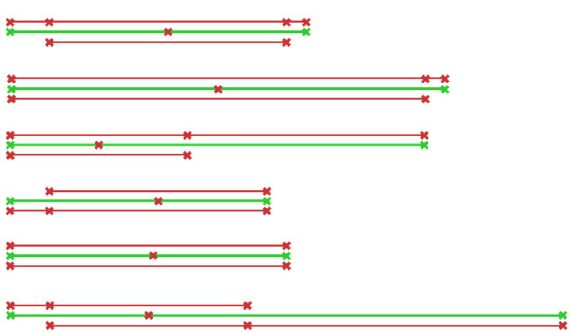
Figure 9 . Some examples of removing double lines by the algorithm. A line is generated (green) in the middle parallel to the neighbouring two lines (red) and of a length that reaches the outermost endpoints of these two lines.